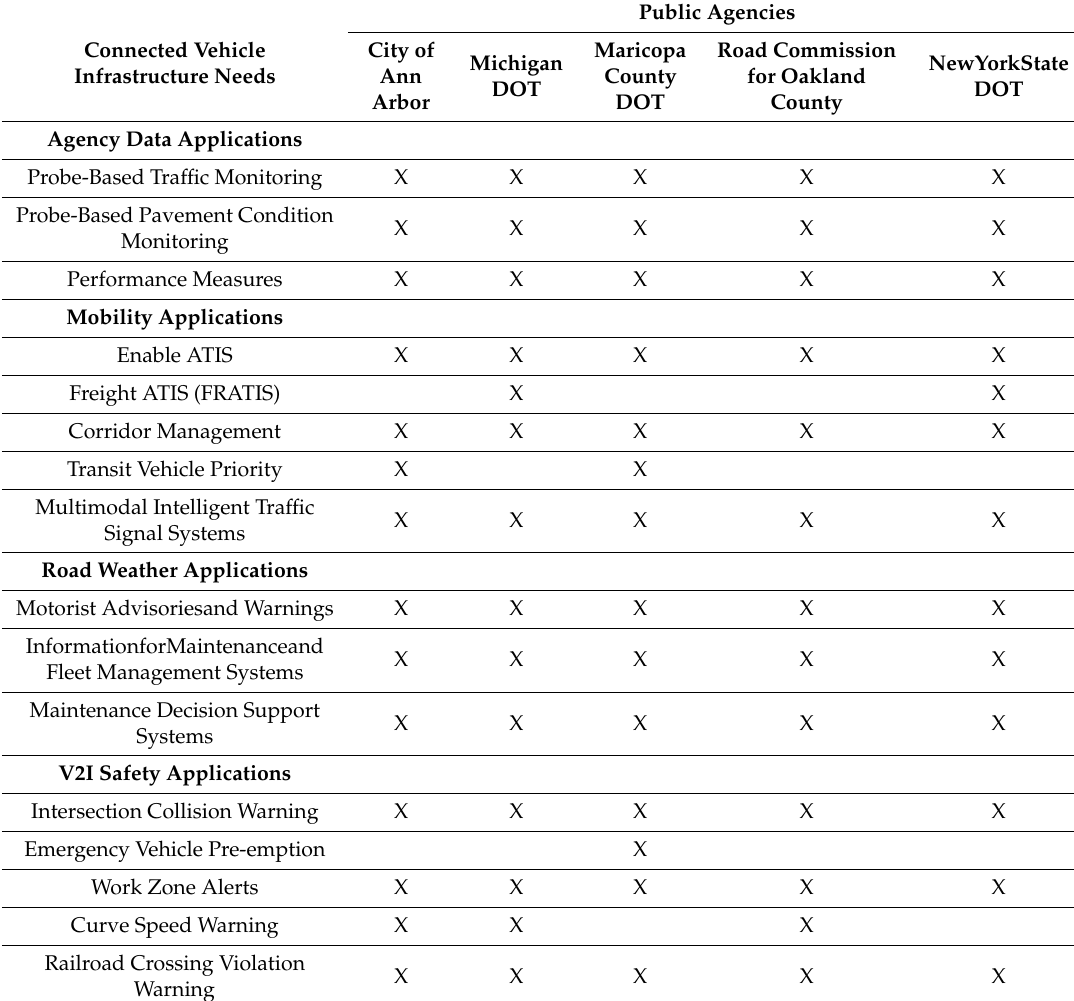
Table 1. V2I Applications Cited by Respondents